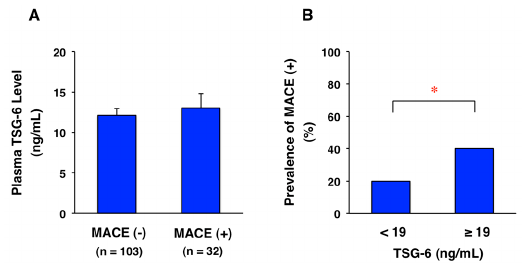
Figure 6. Prediction of prognosis using plasma TSG-6 levels at onset of CAD. Among 135 patients with acute coronary syndrome, 32 patients had major adverse cardiovascular events (MACE) including cardiovascular death, heart failure, acute myocardial infarction, post-infarction angina, and ischemic stroke during a period of four years after onset. The follow-up period was 50.0 ± 0.57 months. ( A ) Plasma TSG-6 levels tended to increase in CAD patients with MACE compared with those without MACE. Data are presented as mean ± SEM. Unpaired Student’s t test was used for statistical analysis. p = 0.6109; ( B ) Prevalence rate of MACE (+) was significantly higher in CAD patients with TSG-6 ≥ 19 ng/mL (40%, 10/25 cases) than those with TSG-6 < 19 ng/mL (20%, 22/110 cases). Chi-squared test was used for statistical analysis. * p = 0.0338. These results are unpublished data from our follow-up study based on our previous report